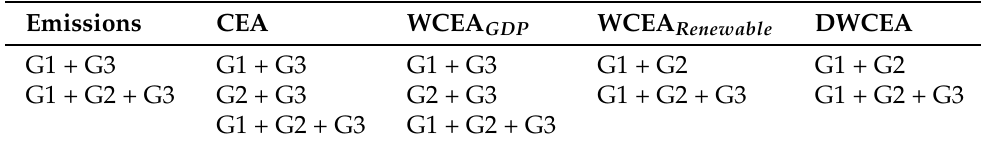
Table 4. Cluster combinations that are able to approve a decision according to the EU Council voting